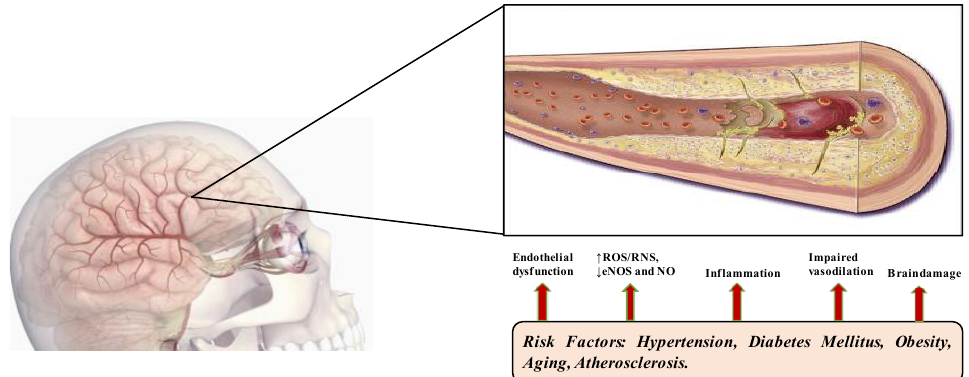
Figure 1. The pathophysiology of ArCSVD is complex and involves various players: the synergy of the altered molecular mechanisms that the various risk factors cause leads to tissue damage; diabetes mellitus, ageing, atherosclerosis, obesity and arterial hypertension cause an inflammatory microenvironment that influences endothelial dysfunction, promotes vasoconstriction by reducing the bioavailability of nitric oxide (NO), promotes the breakdown of the blood–brain barrier and the activation of aberrant immune mechanisms which, in an interminable vicious circle, amplify brain damage.